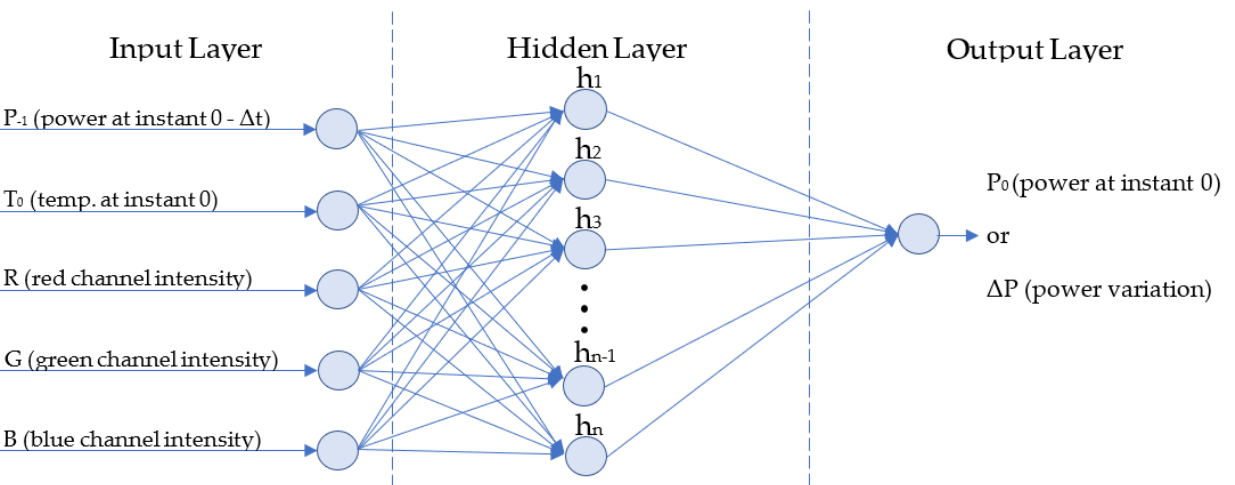
Figure 10. Diagram of inputs, outputs and layers in the tested networks.